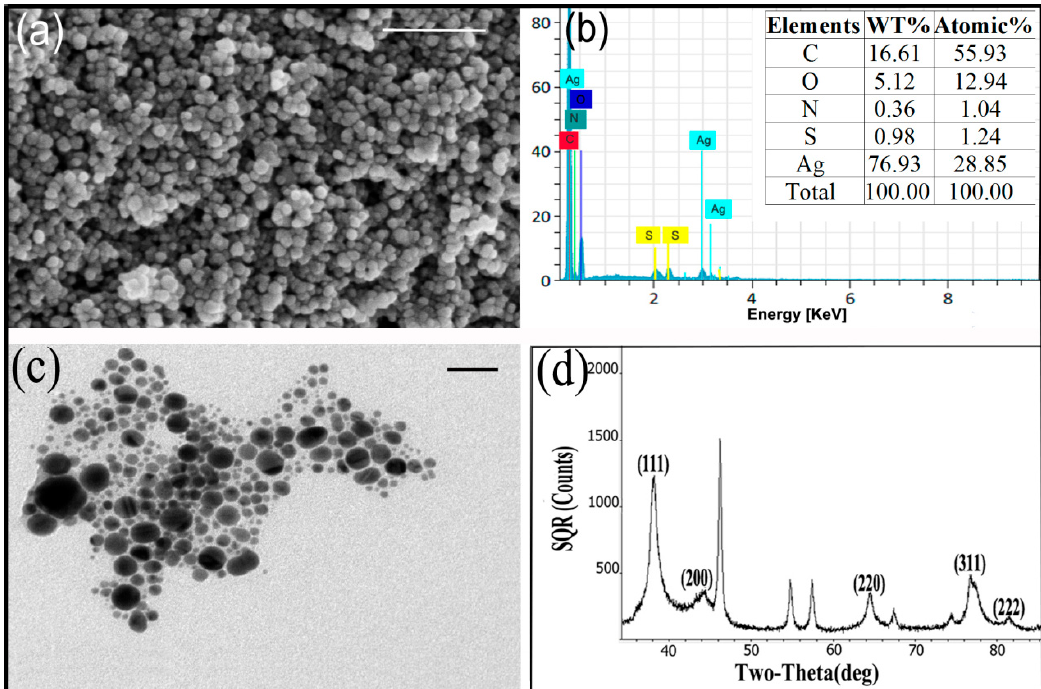
Figure 2. Characterization of the synthesized AgNPs after 120 h of incubation: ( a ) Scanning electron microscopy. Scale bar = 250 nm; ( b ) Energy dispersive spectroscopy; ( c ) Transmission electron microscopy. Scale bar = 50 nm; ( d ) X ‐ ray diffractogram pattern.